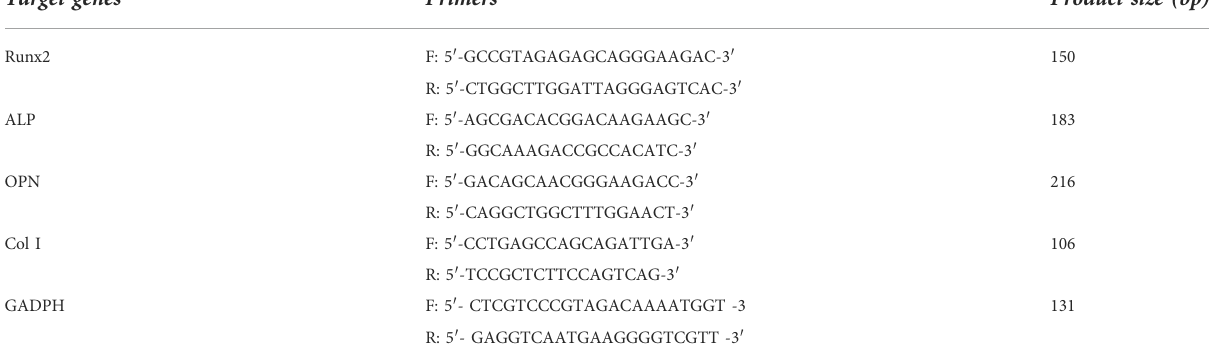
TABLE 2 The chain reaction for real-time polymerase of some osteogenic genes. Target genes